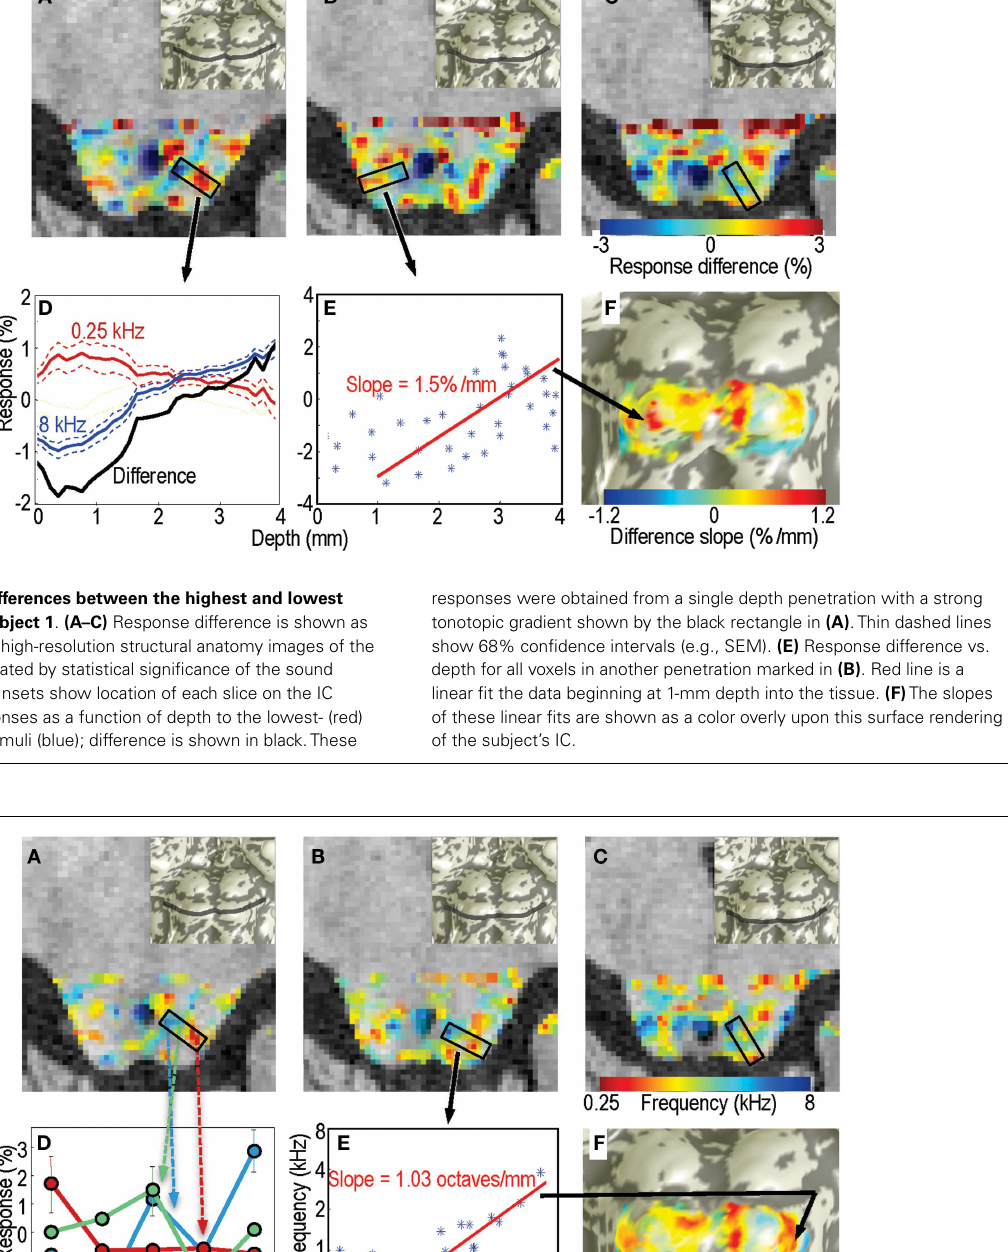
blue near 3.5kHz. (E) Centroid frequency for all voxels in the penetration marked by the black rectangle in (B) . A strong depth gradient that begins 1mm below the surface is captured by the linear fit shown by the red line. (F) The linear fit slope data is marked as a color overlay upon the IC surface